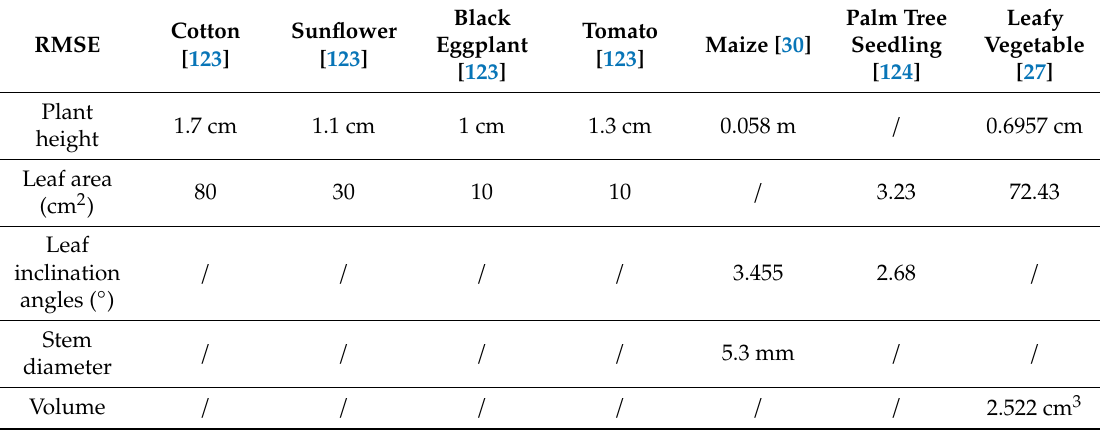
Table 9. Examples of RMSE for plant canopy 3D structure parameters measurement.